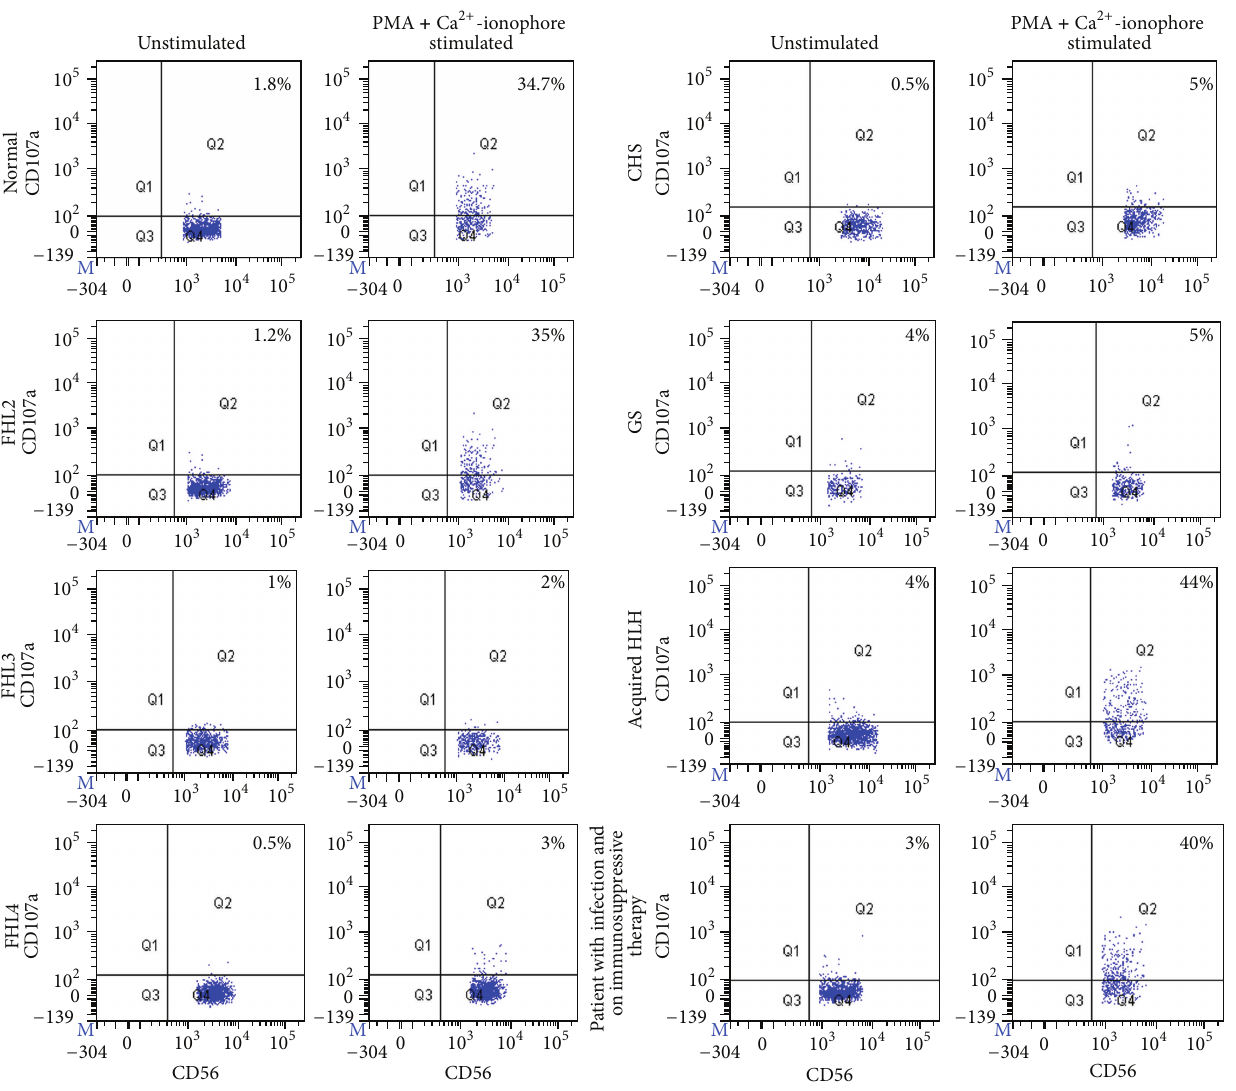
Figure 2: Comparison of CD107a expression on PMA + Ca 2+ ionophore stimulated NK cells. Degranulation assay results are shown from a normal healthy control and patients with FHL2 (mutations in PRF1 encoding perforin), FHL3 (mutations in UNC13D encoding